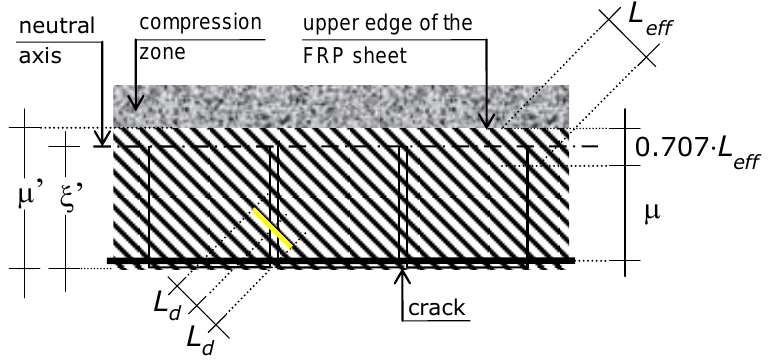
 F d Figure 4. Concrete cantilever that fails (the midspan of the beam is on the right of the figure). On the left: strain profile in the external reinforcement at the two cracked sections that define the lateral sides (boundaries) of the concrete cantilever. The strain is linear, starting from zero at the neutral axis up to  Fd at the right crack and up to '    F-max Fd at the left crack. The external reinforcement bonded onto the concrete cover (which is shadowed) does not transmit any stress. On the right: forces transferred from the longitudinal steel bars (flexural reinforcement) and from the side-bonded reinforcement (the fibers are at 45°) to the concrete cantilever. The latter forces consist in a resisting contribution that makes the effects of the former forces less. The force F is produced by the triangular area of the above-described strain profile. In order to calculate F , two provisional assumptions are made, which will be removed in the following. The first is that there is no bond-slip between externally bonded reinforcement and concrete (not even at the bottom face, where stresses are maximum, which implies that the bottom anchorage length of the FRP reinforcement is adequate). As is well-known, ‘bond-slip’ is an oxymoronic term that means the relative movement of the reinforcement with respect to the surface it is attached onto or embedded into.